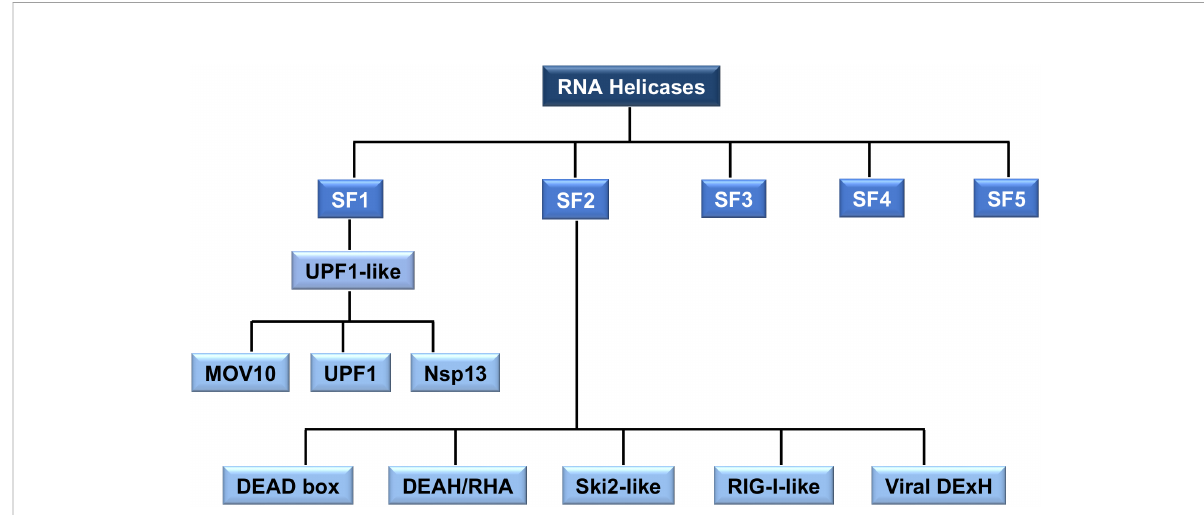
FIGURE 2 The classi fi cation of RNA helicases. All RNA helicases are classi fi ed into fi ve superfamilies (SF) 1-5. SF1 and SF2 are sub-divided into distinct families and groups. SF1 is divided into Upf1-like family. SF2 is divided into fi ve families. SF2 RNA helicase, DEAD box, DEAH/RHA, Ski2-like, RIG- I-like and Viral DExH, are collectively referred to as the DExD/H box of RNA helicases. The type of RNA helicases mentioned in this review, such as MOV10, UPF1, CoV helicase (nsp13), DEAD box and DEAH-box is